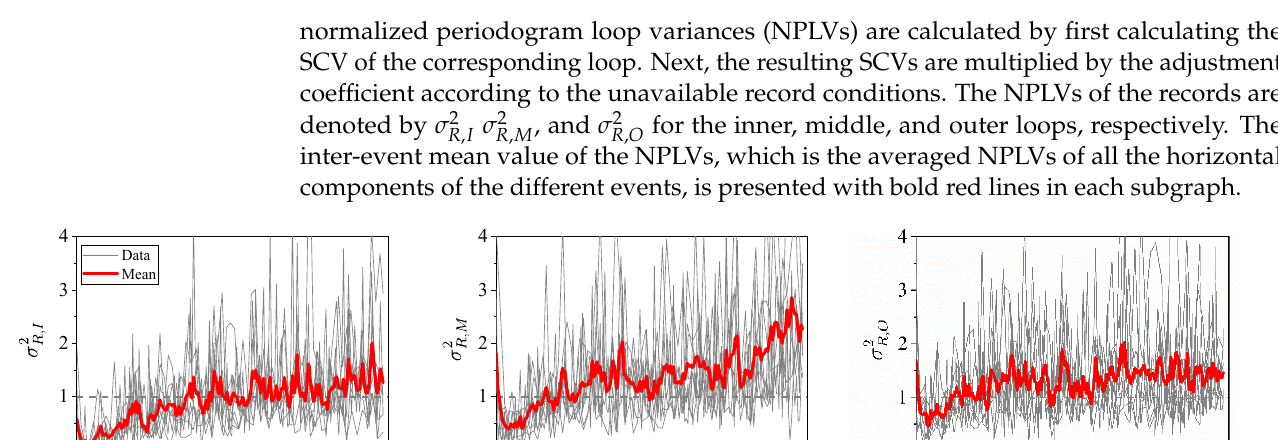
Figure 6. Adjustment coefficient for different loop configurations: ( a ) condition 1, ( b ) condition 2, ( c ) condition 3, ( d ) condition 4, and ( e ) condition 5.